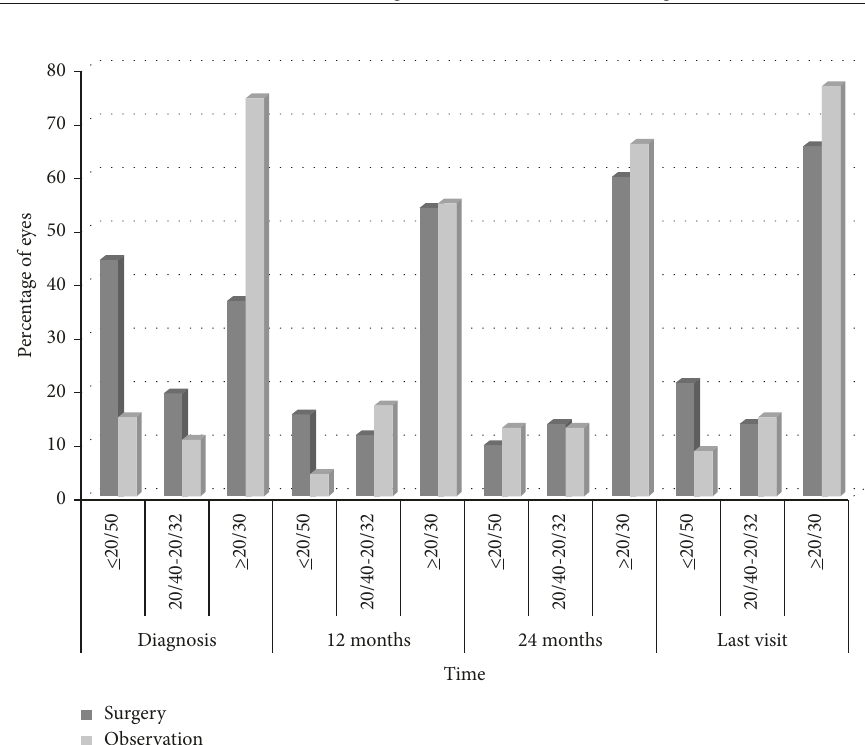
Figure 2: Visual status of eyes with epiretinal membrane in the vitrectomy and observation groups at diagnosis and during follow-up.